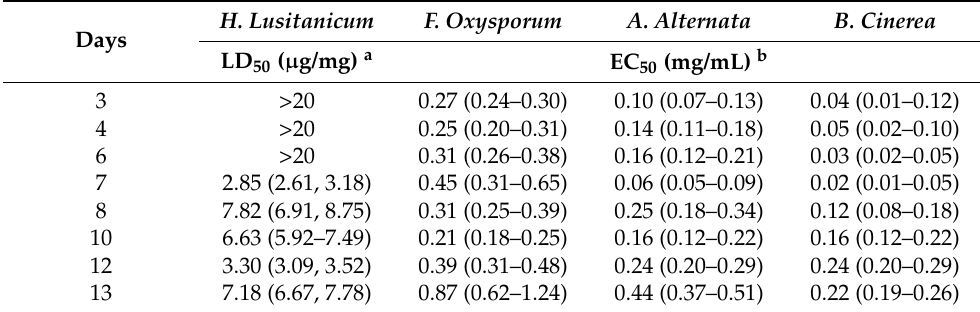
Figure 1. Time course of SPH2 mycelial and extract yield Table 1. The ethyl acetate extracts from SPH2 were screened for their biocontrol properties against plant pathogens ( Fusarium moniliforme , Alternaria alternata, and Botrytis cinerea ) (Tables 2 and 3), insect pests ( Spodoptera littoralis , Myzus persicae , Rhopalosiphum padi ) (Table S1) a plant parasitic nematode ( Meloidogyne javanica ) (Table S2) and ticks ( Hyalomma lusitanicum ) (Table 2). Extracts from days 3–13 showed significant fungicidal and ixodicidal effects. The antifungal effects on B. cinerea and A. alternata , the most sensitive species, were stronger between days 3 and 7 of incubation, while the ixodicidal effects started on day 7 (the most active extract) and were maintained until day 13 (Table 2). These extracts were not antifeedant or nematicidal (Tables S1 and S2). Table 2. Ixodicidal activity on Hyalomma lusitanicum larve (mortality) and antifungal (mycelial growth inhibition) on Fusarium oxysporum, Alternaria alternata, Botrytis cinerea , of the time-course SPH2 extracts.